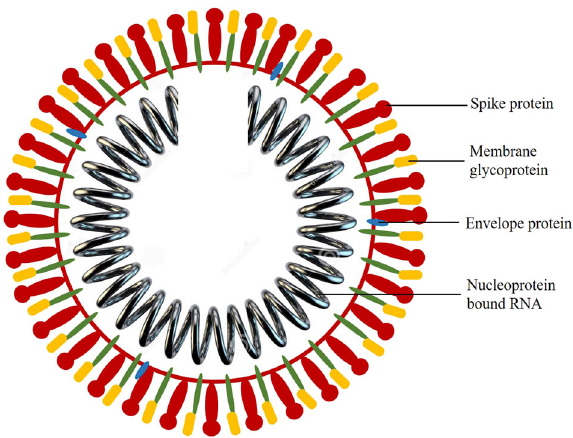
Fig. 1 The virion structure of